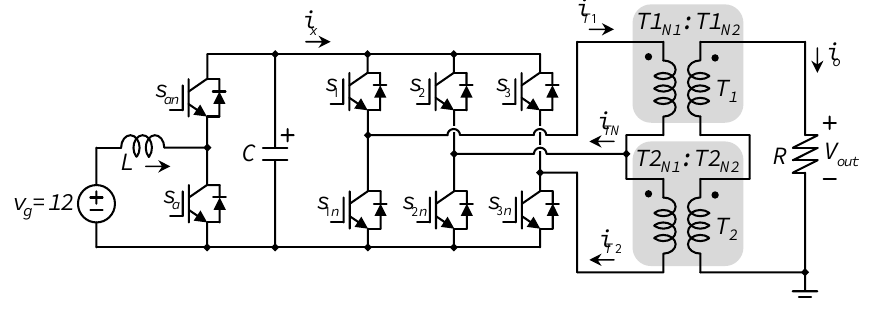
Figure 3. The entire conversion system with the proposed five-level inverter topology.